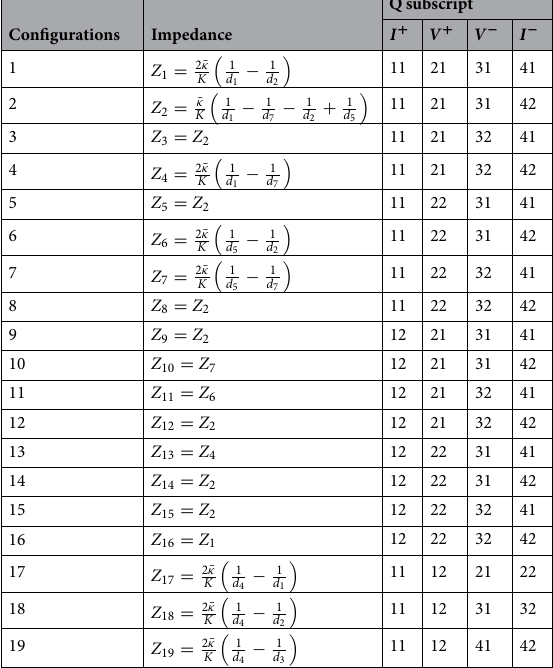
Table 2. Table of the nineteen configurations in Fig. 4 with its impedance equation (11) and the electrode involved for each